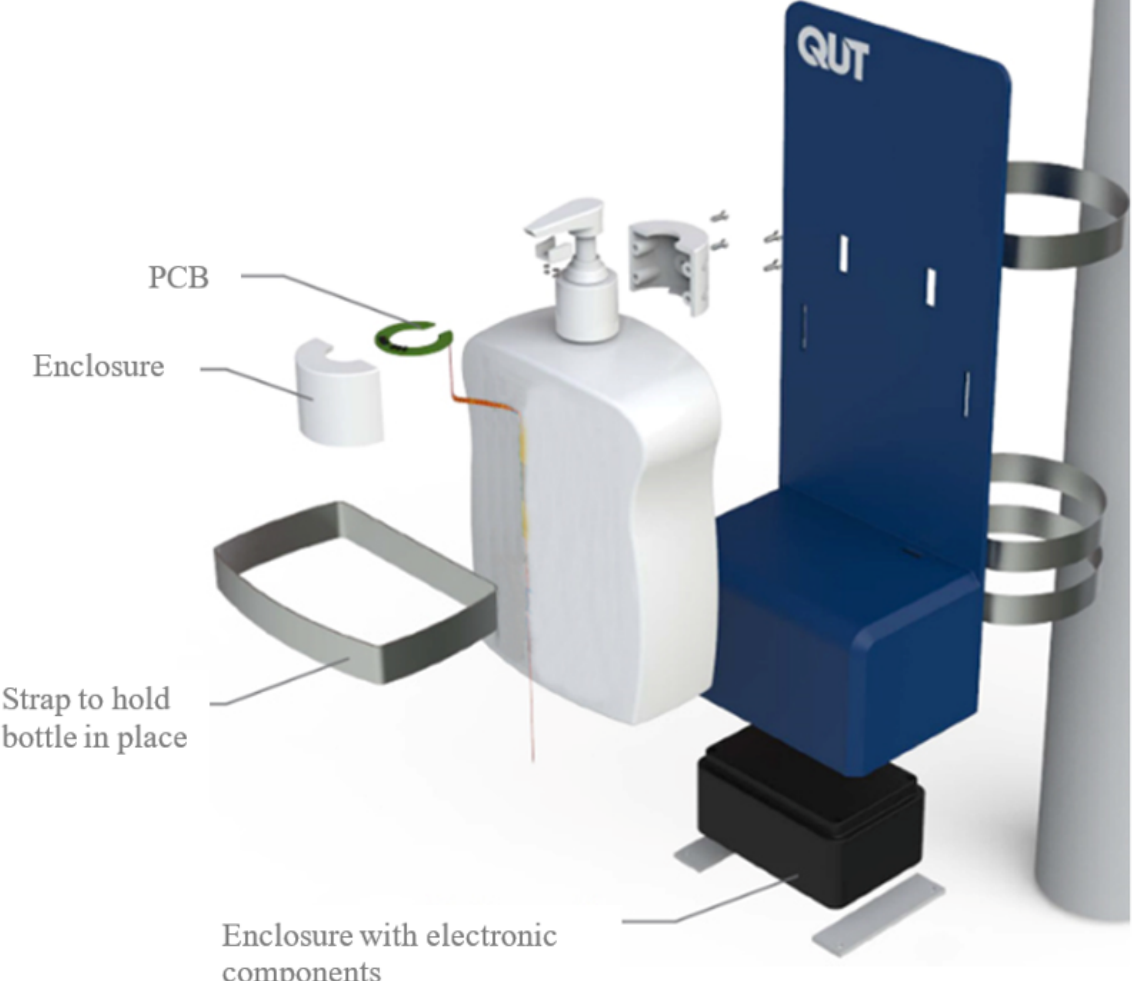
Figure 2. Smart sunscreen station housing with electrical components housed within the bottom of the stand and stainless steel strapping to secure the bottle in place. PCB: printed circuit board.